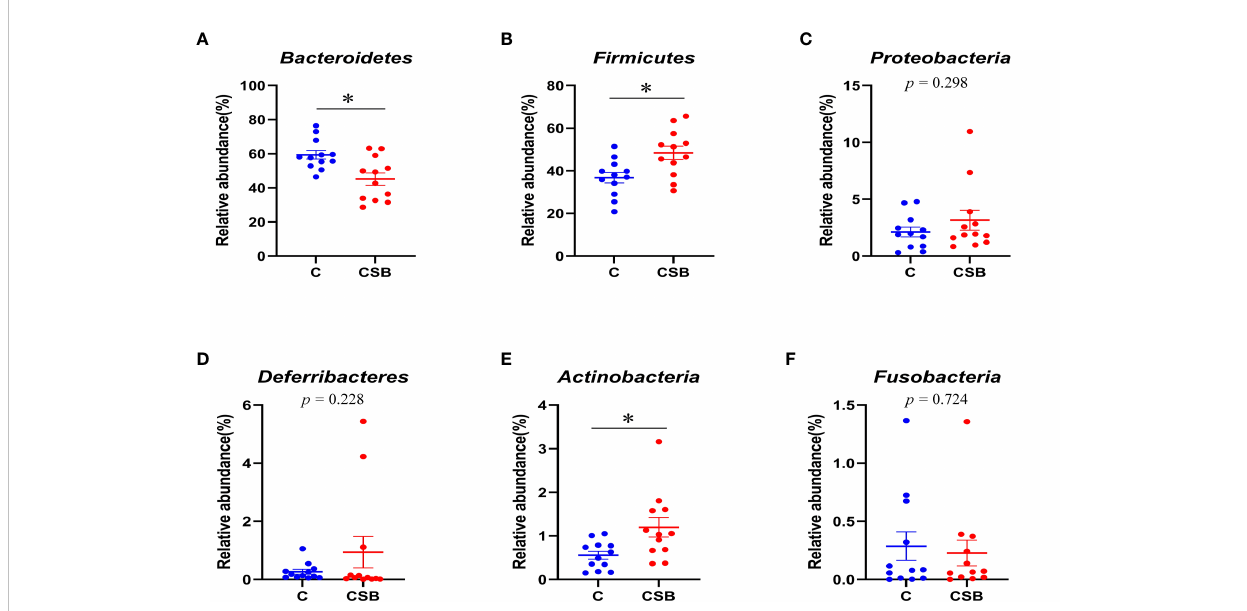
FIGURE 8 Effects of dietary supplementation of coated sodium butyrate (CSB) on the relative abundance of cecal microbiota of laying ducks at the genus level. (A) Bacteroides. (B) Faecalibacterium. (C) Megamonas. (D) Subdoligranulum. (E) Desulfovibrio. (F) Prevotellaceae_Ga6A1_group. Values are presented as means ± SEM (n = 12). * p< 0.05. group C, Control group, which was fed a basal diet; CSB group, CSB-treated group, which was fed the basal diet supplemented with 250 g/t of CSB.